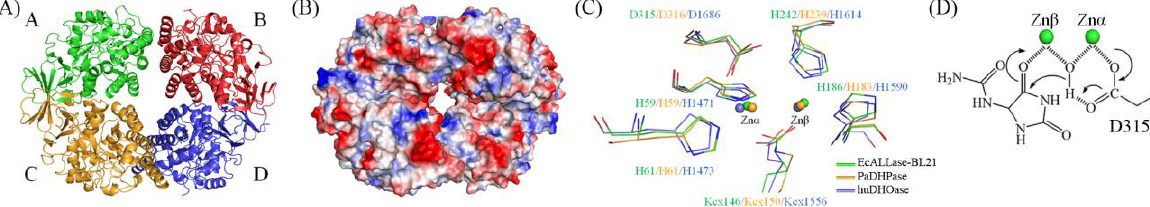
Figure 3. Structure of EcALLase-BL21. ( A ) Ribbon diagram of EcALLase-BL21 tetramer. Each ScDHOase monomer is color coded. Two zinc ions in the active site are presented as black spheres. ( B ) The electrostatic potential surface of EcALLase-BL21. Tetramerization of EcALLase-BL21 monomers generated a central cavity but it is unclear what function, if any, it was created for. ( C ) Superposition of the active site of members of the cyclic amidohydrolase family. Their active sites contain four His, one Asp, and one Kcx, which are required for di-metal binding and catalytic activity. EcALLase-BL21 (PDB ID 8HFD; green), PaDHPase (PDB ID 5E5C; light orange), and huDHOase (PDB ID 8GW0; slate) are shown. The architecture of these active sites is similar. ( D ) The proposed mechanism of EcALLase-BL21 for catalysis. The hydrolysis of allantoin likely undergoes three steps: the hydrolytic water molecule must be activated for nucleophilic attack, the amide bond of the substrate must be made more electrophilic by polarization of the carbonyl–oxygen bond, and then the leaving-group nitrogen must be protonated as the carbon–nitrogen bond is cleaved. The metal ions are shown as green